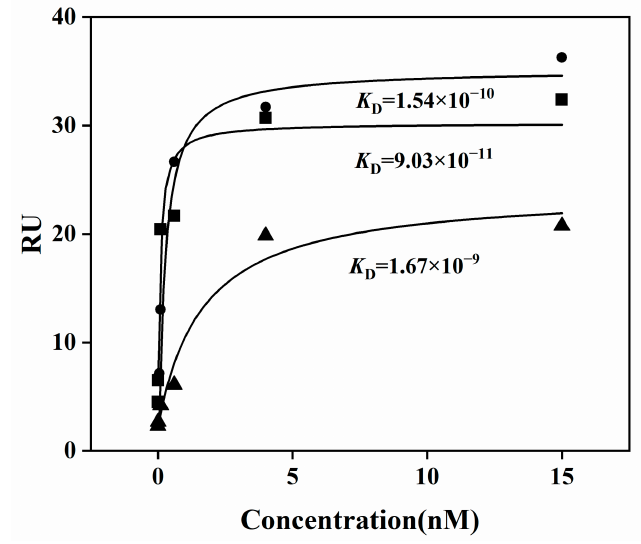
Figure 5. Surface plasmon resonance analysis of the interaction of the respective endotype xan- thanases with xanthan. The dissociation constant ( K D ) values were calculated using a one-site steady state binding